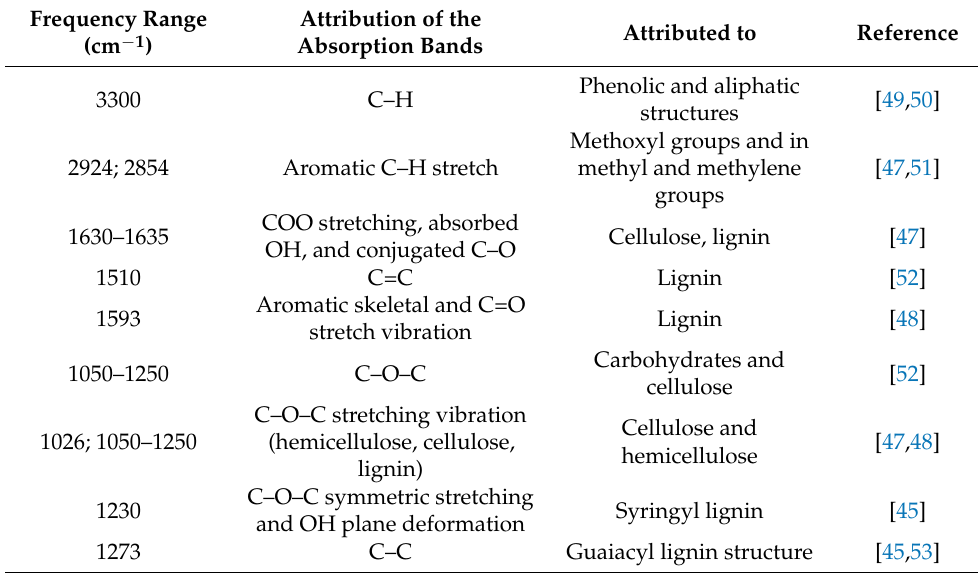
Table 3. The characteristic signal bands assignments of the main peaks of softwood and hardwood after hydrothermal